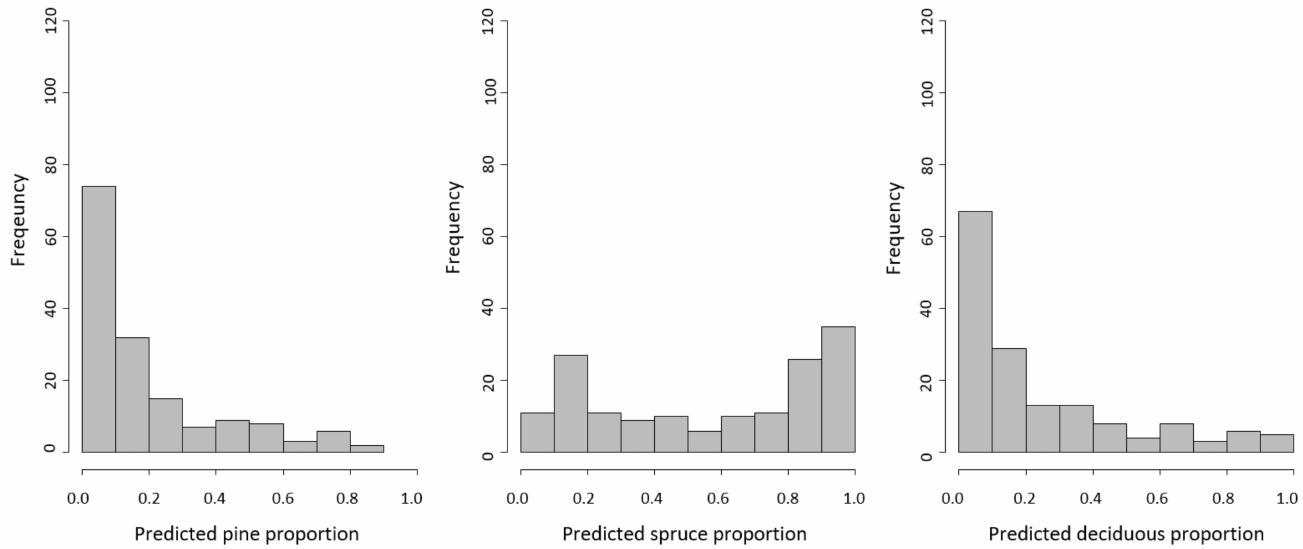
Figure 4. Histograms of predicted pine, spruce and deciduous proportion (left to right) shown in 10% interval classes of 156 plots for the best performing model-based predictions on image